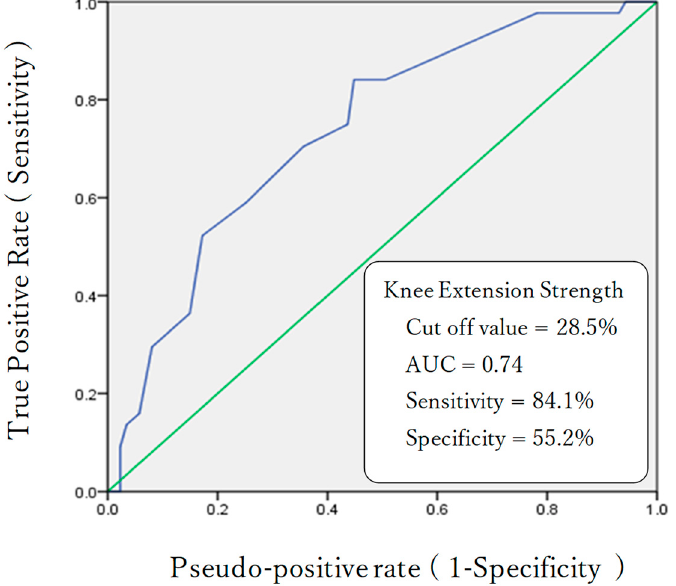
Figure 2. Receiver Operating Characteristic curve for delineating knee extension strength for the use of walking aids. AUC: Area Under the Curve.